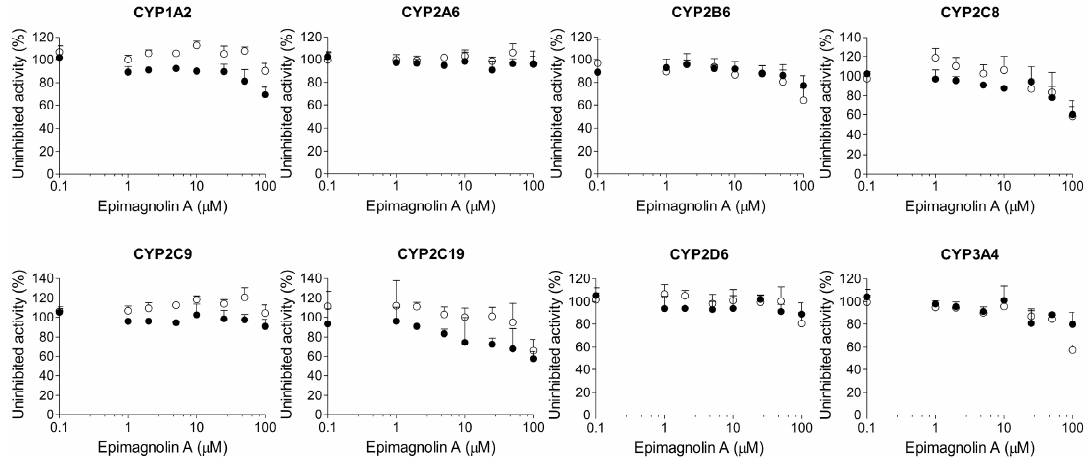
Figure 4. Inhibitory effects of epimagnolin A on CYP1A2-mediated phenacetin O -deethylation, CYP2A6-mediated coumarin 7-hydroxylation, CYP2B6-mediated bupropion hydroxylation, CYP2C8-mediated amodiaquine N -deethylation, CYP2C9-mediated diclofenac 4’-hydroxylation, CYP2C19-mediated [ S ]-mephenytoin 4’-hydroxylation, CYP2D6-mediated bufuralol 1’-hydroxylation, and CYP3A4-mediated midazolam 1’-hydroxylation in pooled human liver microsomes. : Pre-incubation of liver microsomes with epimagnolin A and NADPH for 30 min at 37 °C, : No pre-incubation. Data represent the average ± SD ( n = 3).